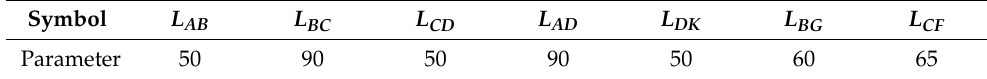
Table 2. Parameters of the connecting rods of the underactuated mechanism (unit: